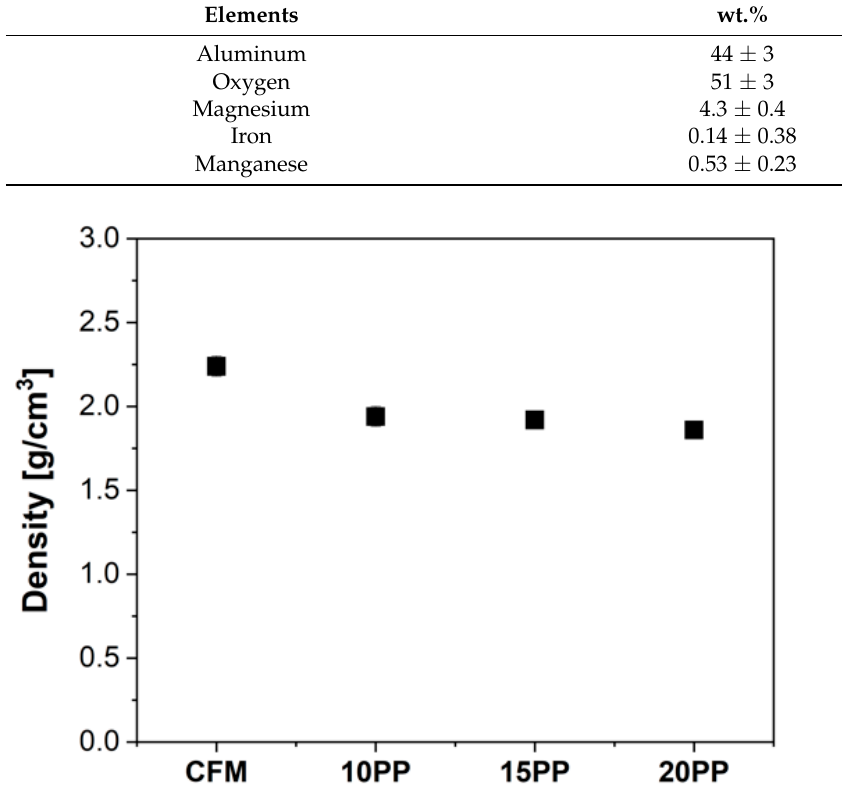
Figure 5. Density of reference CFM and with PP waste additions.